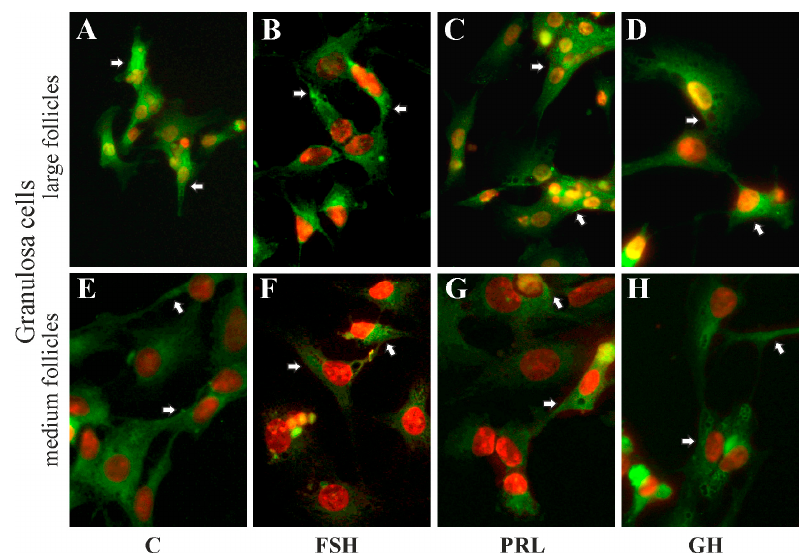
Figure 5. The influence of FSH, PRL and GH on subcellular distribution of AQP1 in granulosa cells of medium and large porcine ovarian follicles. Cells were exposed to FSH ( B , F ), PRL ( C , G ) and GH ( D , H ) for 24 h. The cells were fixed and incubated with anti-AQP1 antibody. Alexa-488 was used to visualize AQP1 (in green). Nuclei were stained with propidium iodide (in red). Arrows indicate localization of AQP1 in the cells. The data are representative of five separate experiments, each performed in duplicates. C: control ( A , E ); magnification of 600×.